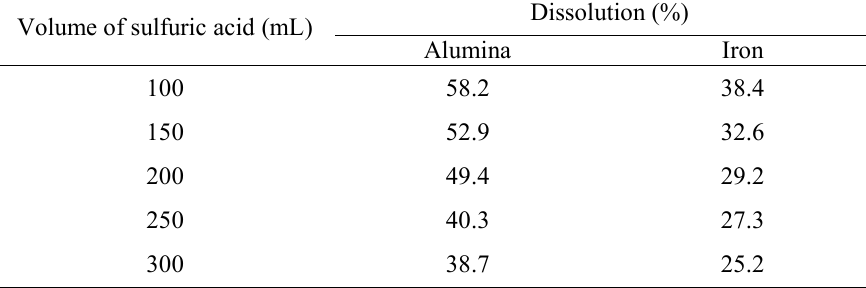
Table 8. Effect of the volume of sulfuric acid (0.5M) on the extraction of alumina and iron with a 2:3 ratio of calcined clay to ammonium sulfate, calcinations at 400 o C for 120 min, and a reaction temperature of 90 o C for 180